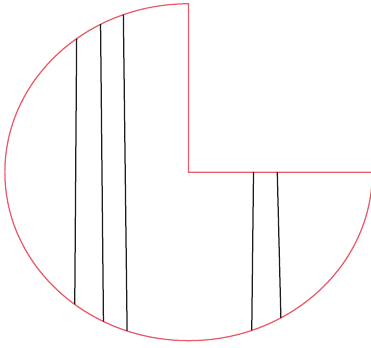
Figure 2: Sheet model in Scheme